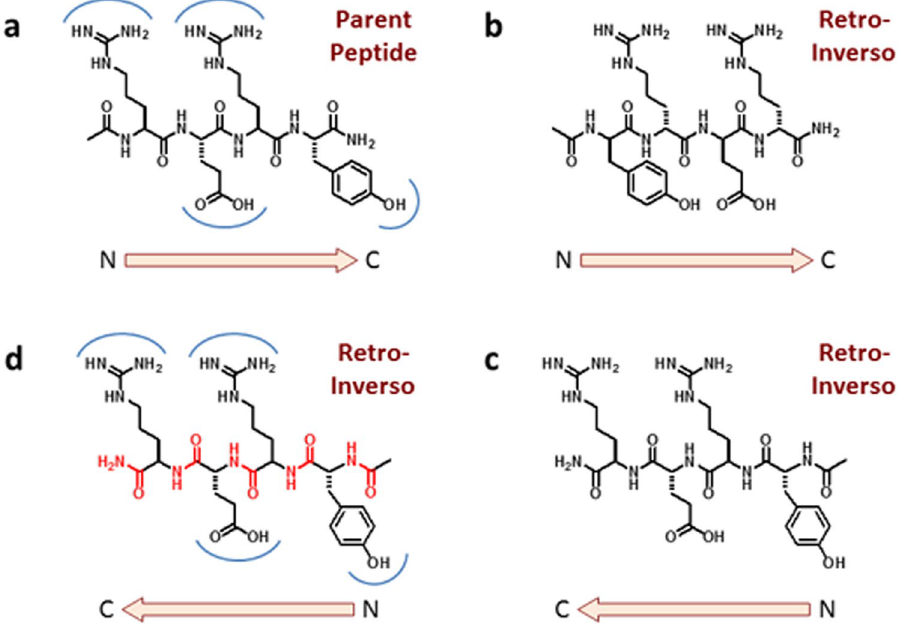
Figure 1. Topological relationship between a peptide and its totally retro-inverso analog, illustrated for Peptide RI-1. ( a ) Parent peptide Ac-Arg-Glu-Arg-Tyr-NH 2 and ( b ) the corresponding totally Retro-Inverso (RI) analog Ac-(D)-Tyr-(D)-Arg-(D)-Glu-(D)-Arg-NH 2 . The arrow indicates the direction (N-to-C) of the peptide backbone. The blue arcs in ( a ) indicate the binding sites of the side chains. ( c ) The RI peptide in the C-to-N orientation. The topology of the side chains is the same as the parent peptide in the N-to-C orientation. ( d ) In the C-to-N orientation, the side chains of the retro-inverso peptide can occupy the same binding pockets of the parent peptide, while the peptide backbone (red) is inverted, hence the H-bonding pattern is not maintained. The positions of the end-groups are also not